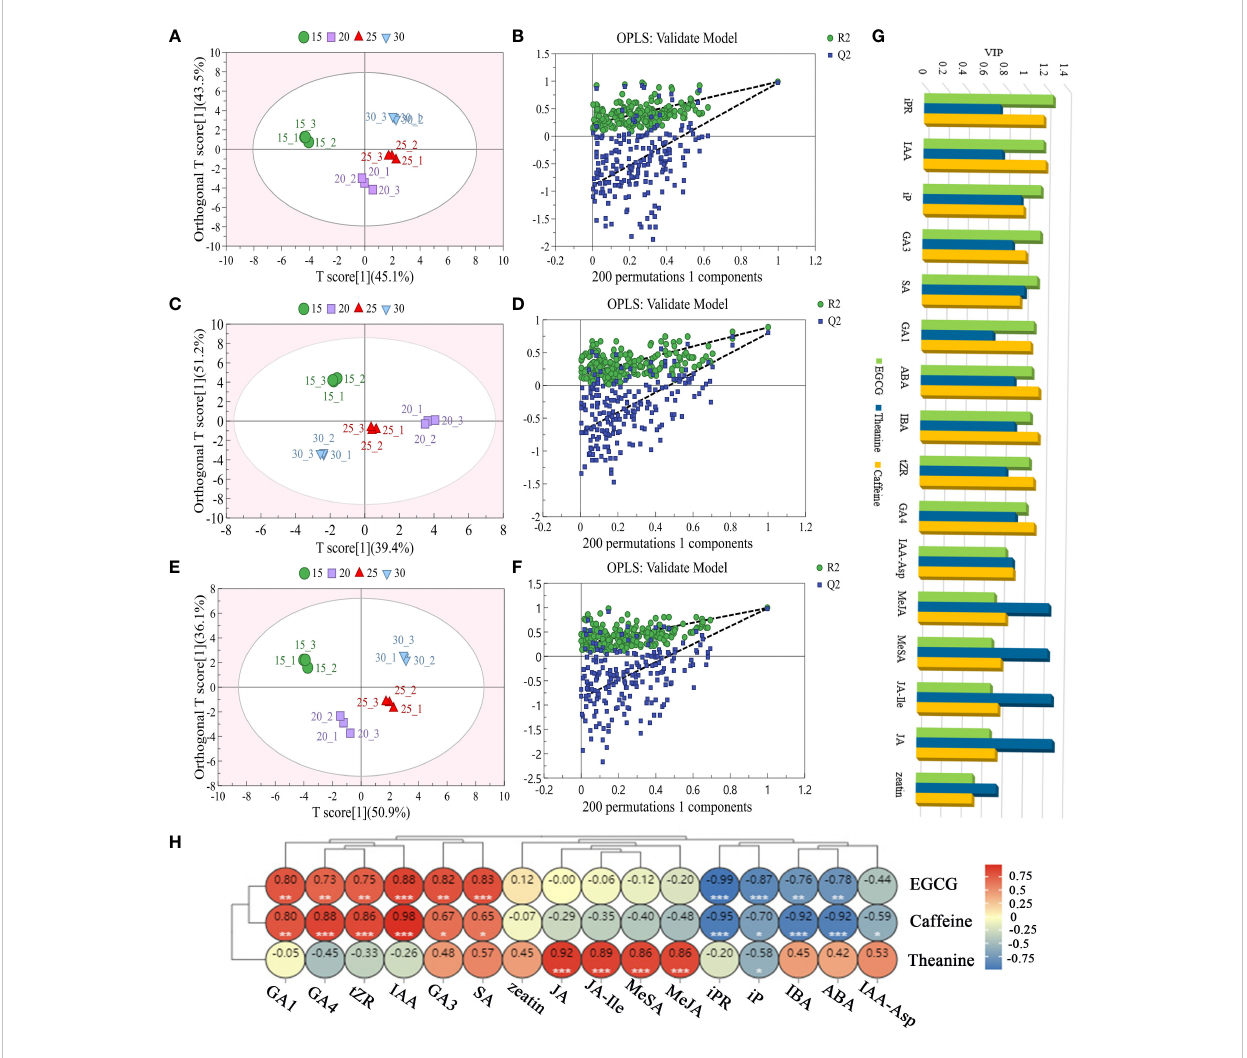
FIGURE 2 Relationship between the content variations of endogenous hormones and three main taste components in tea plant at different temperature treatments. The score plots (A, C, E) and the cross-validation plot (B, D, F) of EGCG, theanine, caffeine and 16 endogenous hormones respectively. VIP values (G) and Pearson correlation analysis (H) of EGCG, theanine, caffeine and 16 hormones contents in tea plant at different temperatures. * Signi fi cance level 5% (P < 0.05), ** Signi fi cance level 1% (P < 0.01), *** Signi fi cance level 0.1% (P <